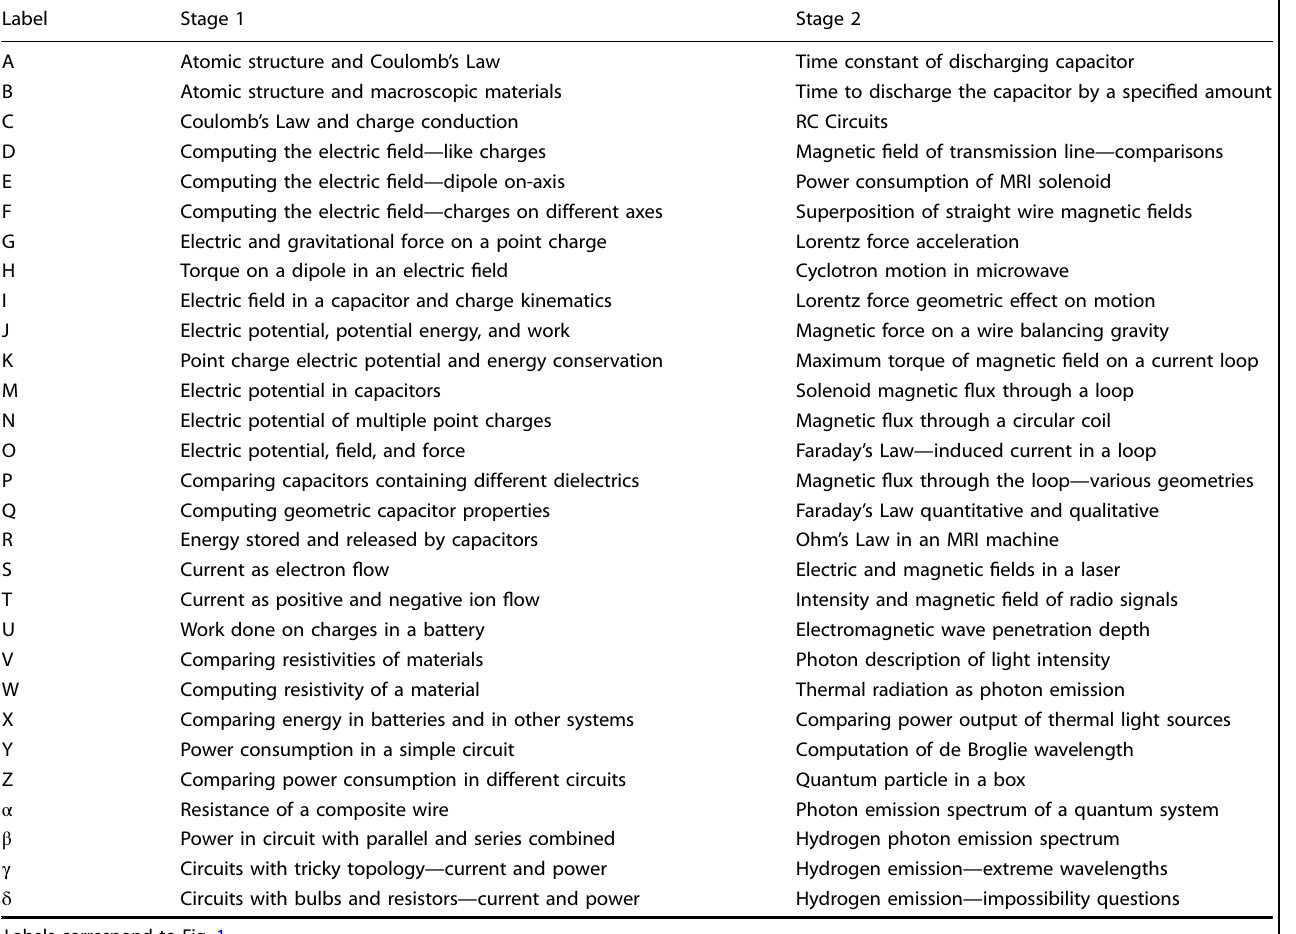
Table 1. List of topics covered in stages 1 and